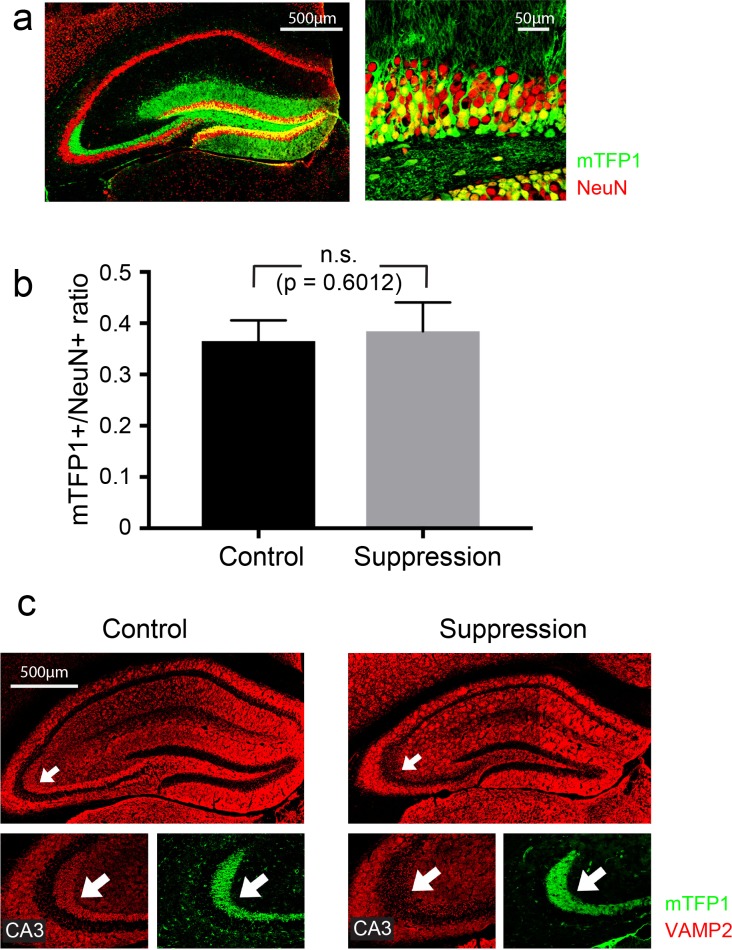
Suppression of hippocampal postnatally-born neurons with mGfap-Cre::vGlut1-LSL-TeNT targeted a larger fraction of DG neurons than ABN ablation. (A) Hippocampal section of a mGfap-Cre::R26-CAG-LoxP-HA-mTFP1 mouse (Imayoshi et al., 2012). Targeted neurons are labeled with mTFP1. Green: mTFP1; red: NeuN. Left: hippocampus; right: DG granule cell layer. (B) The fractions of targeted neurons in control (mGfap-Cre::R26-CAG-LoxP-HA-mTFP1) and suppression (mGfap-Cre::vGlut1-LSL-TeNT::R26-CAG-LoxP-HA-mTFP1) groups are comparable (p=0.6012, Student's t-test; mean ±S.E.M.), with both much higher than that of ABN ablation. Our ABN ablation lasts no more than 3 months (Figure 1B), with an estimation of <10% cell loss in the DG (Imayoshi et al., 2008). (C) Hippocampal sections of control and suppression mice stained for VAMP2 antibody. Arrows indicate the mossy fibers in CA3 which consist of DG granule cell axons. The suppression mouse shows a marked decrease in VAMP2 staining, indicating the functional expression of TeNT in many DG granule cells.